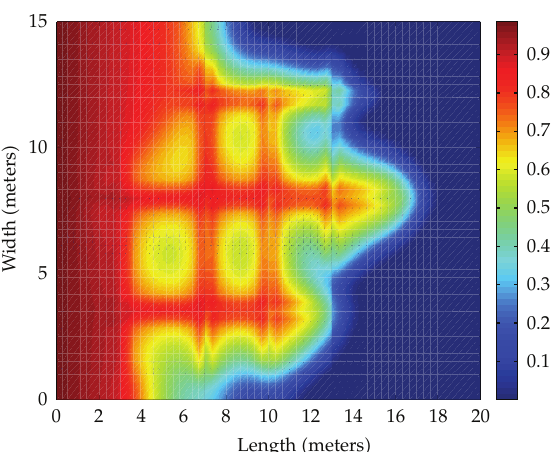
Figure 8: Water saturation profile at 0.5 PVI by the proposed method: Example